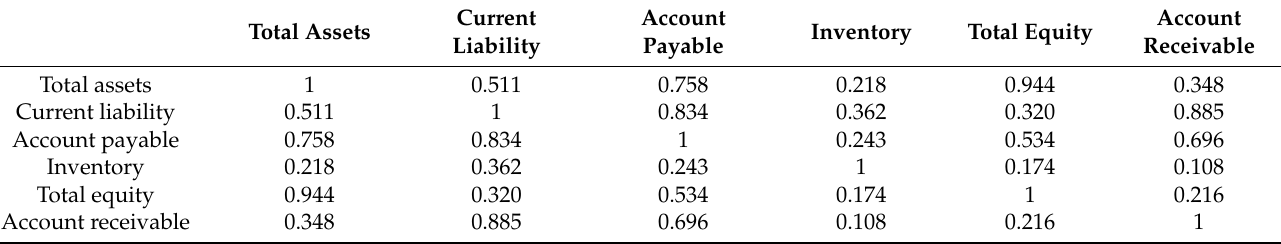
Table 8. Correlation of input and output data in 2020.